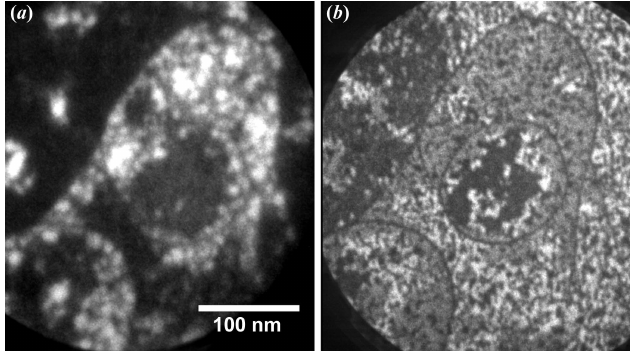
Figure 8 High-resolution secondary ( a ) XPEEM and ( b ) LEEM images of Sn/ SnO x intercalated graphene. For the XPEEM image, every frame was acquired with 1 s exposure time in the stack of 185 images. Before integration, the images in the stack were drift-corrected. For the LEEM image, the image was integrated from eight frames with 1 s exposure time without drift correction (note that the single step is clearly visible in both images).